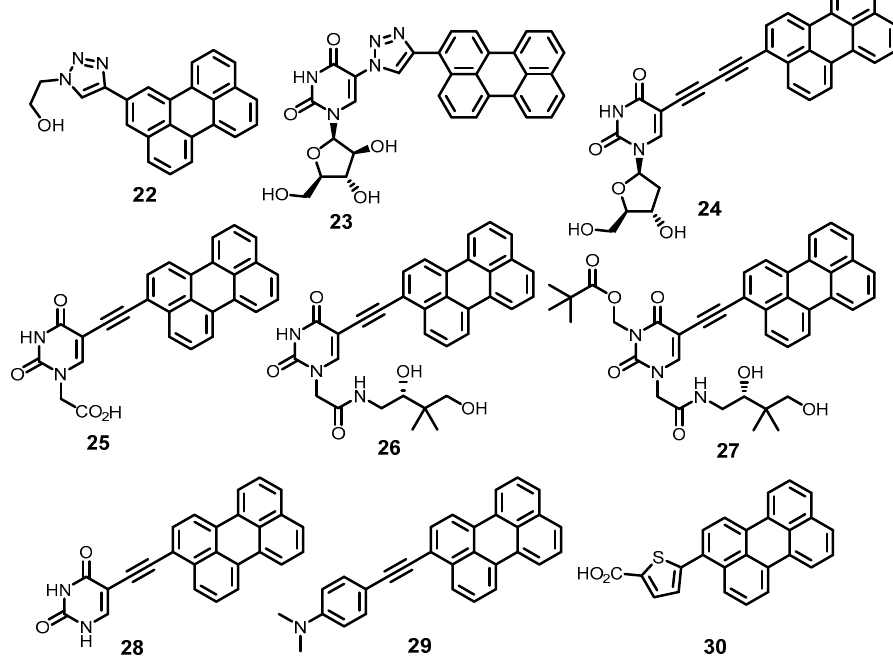
Figure 7. Other antiviral perylene derivatives.